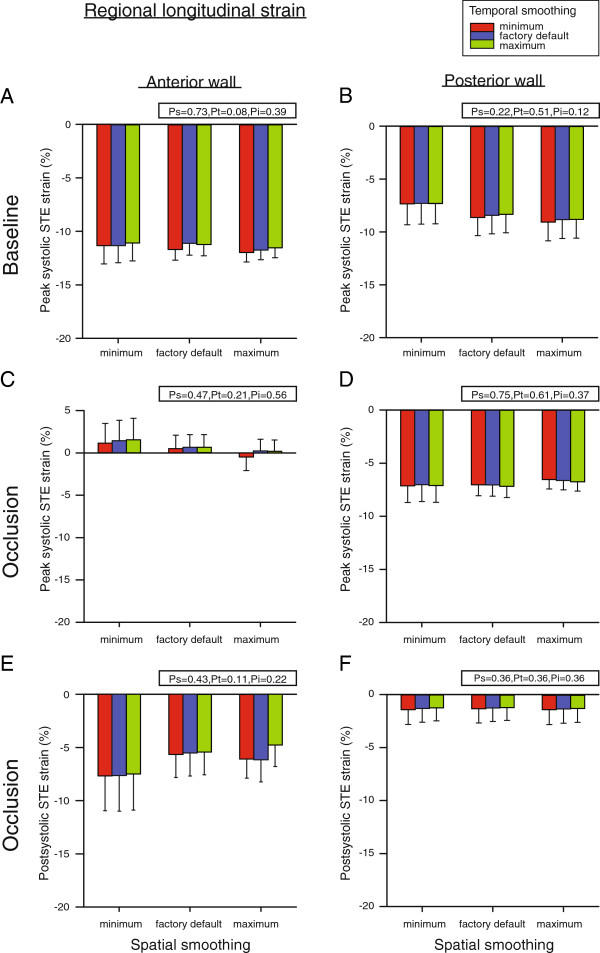
Regional longitudinal peak- and postsystolic Speckle Tracking Echocardiography (STE) strain in the anterior and posterior myocardial wall at baseline (A and B) and after left anterior descending coronary artery occlusion (C - F). Measurements were performed with nine different combinations of spatial and temporal smoothing created by setting these parameters in turn to minimum, factory default and maximum. Mean values of seven animals, error bars represent SEM. Ps, Pt and Pi as defined in Figure 4.